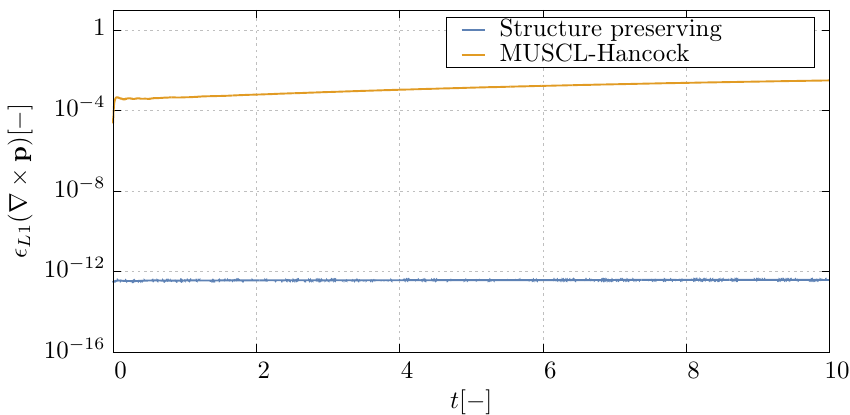
Figure 5. Time-evolution of the L 2 norm of the discrete curl errors when a staggered compatible curl- free discretization is used (blue) and when no staggering is in effect (orange), for the non-condensing bubble test case. For both simulations, the parameters are γ = 2 µ = 10 − 2 , c s = 10. The computational domain is Ω c = [ 1024 1024 cells. ×